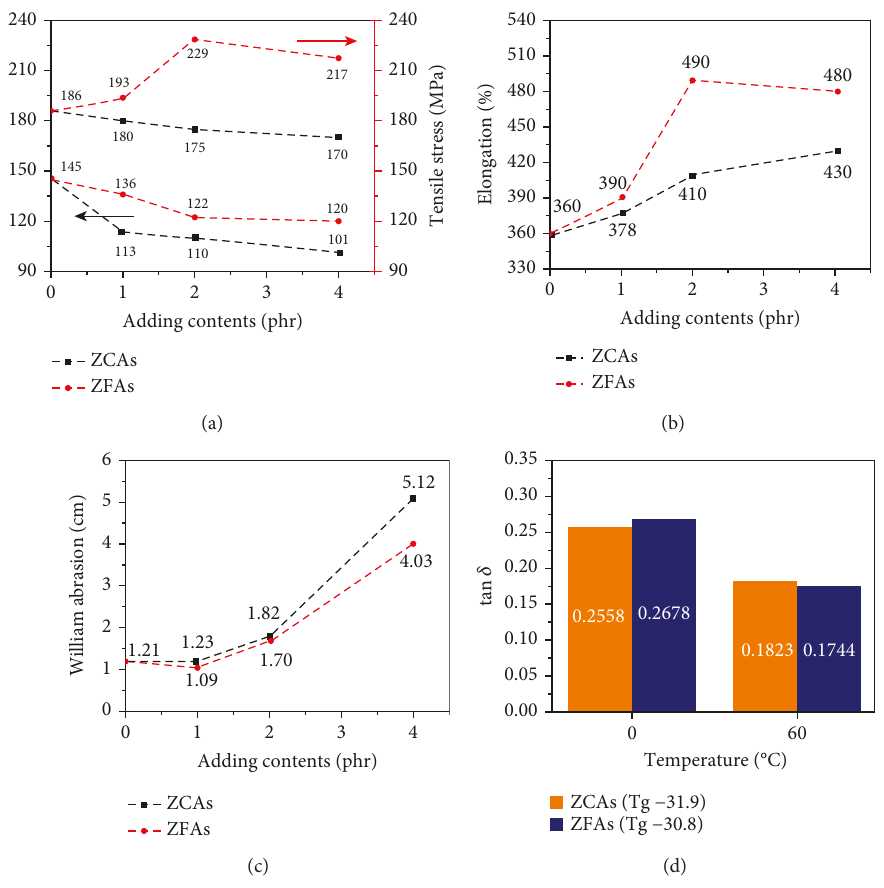
Figure 2: (a) Modulus and tensile strength, (b) elongation, (c) William abrasion, and (d) dynamic properties ( tan δ ) of rubber composites with zinc ion-containing processing aids (ZCAs) and